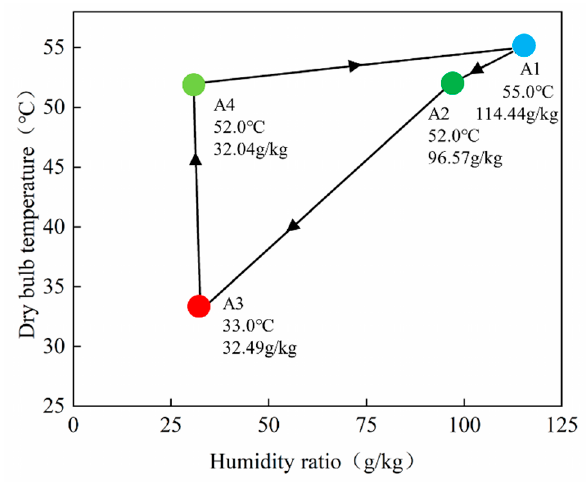
Figure 3. Psychometric chart of the proposed humidification–dehumidification (HDH) process.